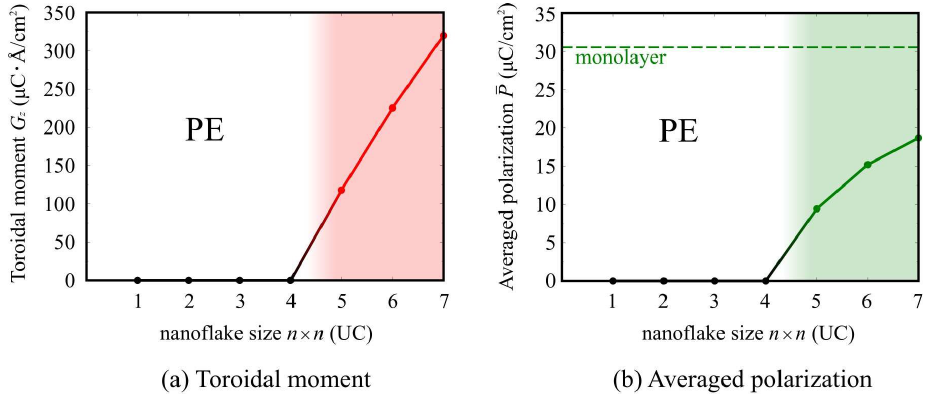
Figure 8. ( a ) Toroidal moment, G , and ( b ) averaged polarization, P , in SnTe nanoflake as a function of SnTe nanoflake size. The green dotted line indicates the polarization of the SnTe monolayer. PE indicates the paraelectric phase.